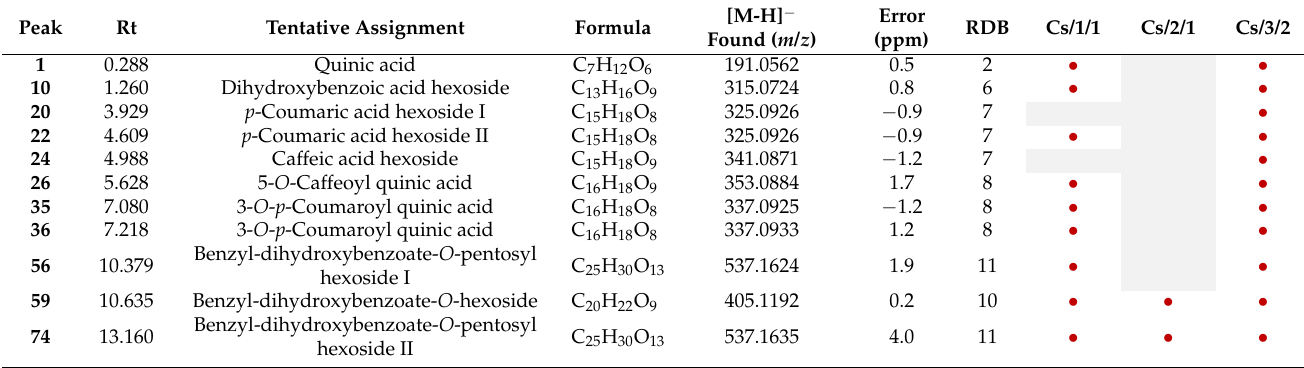
Table 1. Quinic acid and phenolic acid glycosides tentatively identified in the chestnut Cs/1/1 alcoholic extract and its Cs/2/1 and Cs/3/2 fractions. RT = retention time; RDB = ring double bond equivalent value. Base peak fragments are reported in bold. • Detected (Grey color box = not detected).